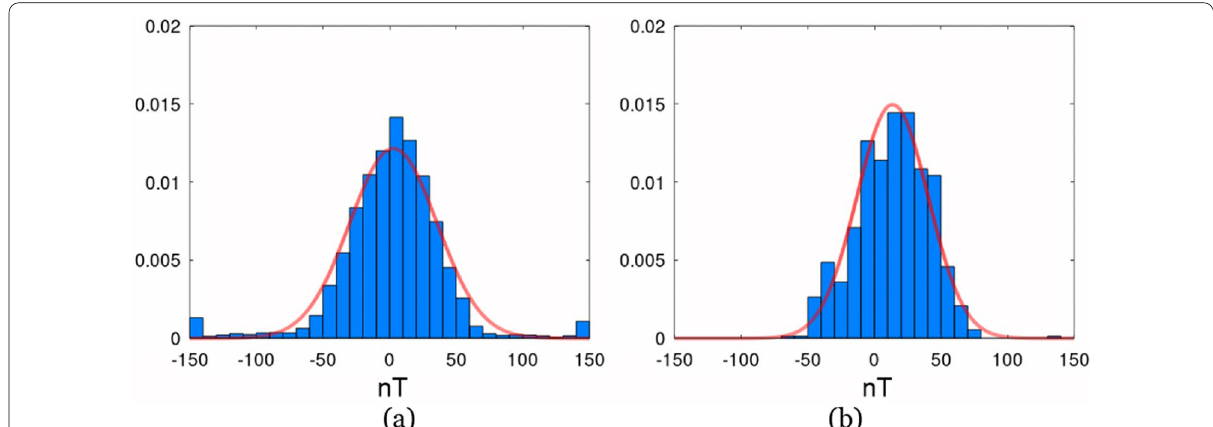
Fig. 2 Histograms of the distribution for the differences in the total intensities derived from the IGRF model and directly measured by the Kosmos-49 ( a ) and Kosmos-321 ( b ) satellites. Red curve shows the modelled Gaussian distribution function that best fits the empirical distribution